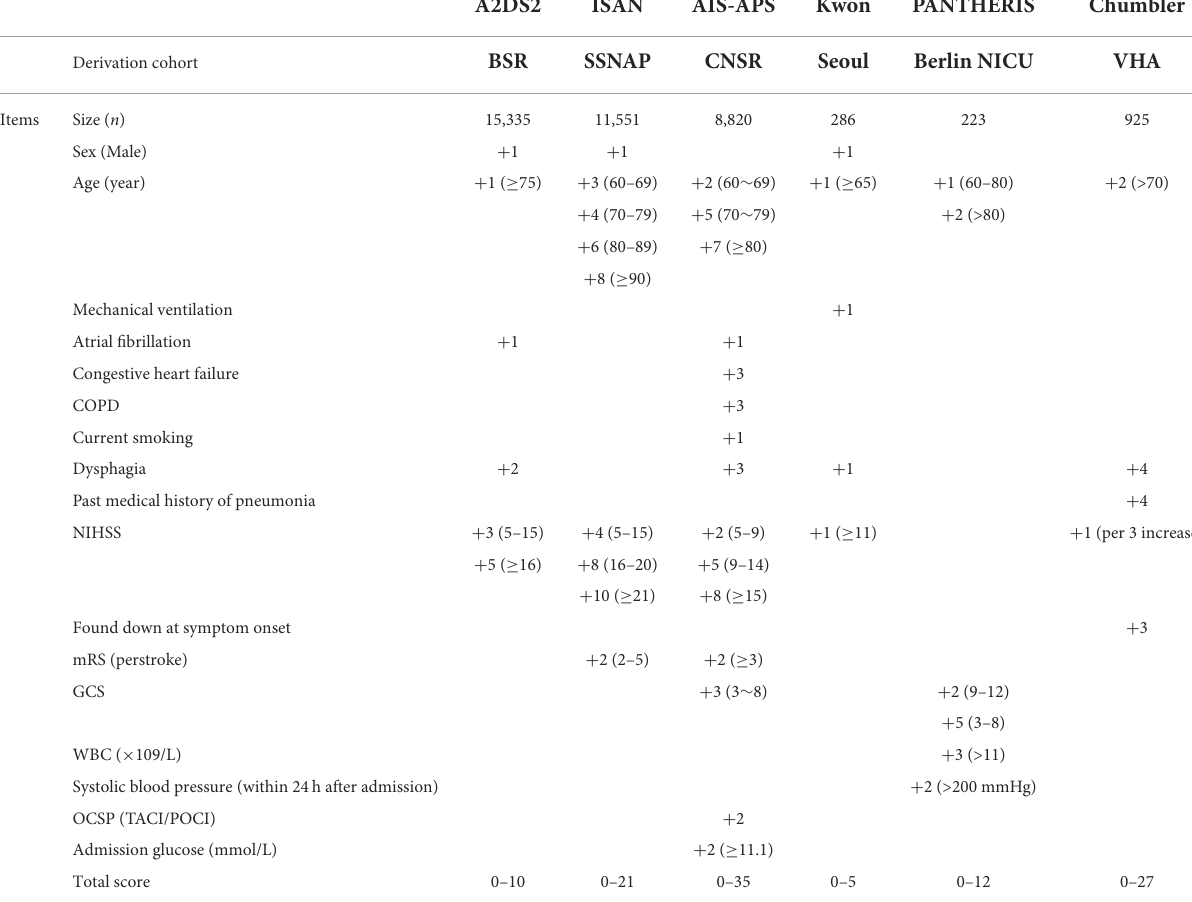
TABLE 3 The details of the six scoring